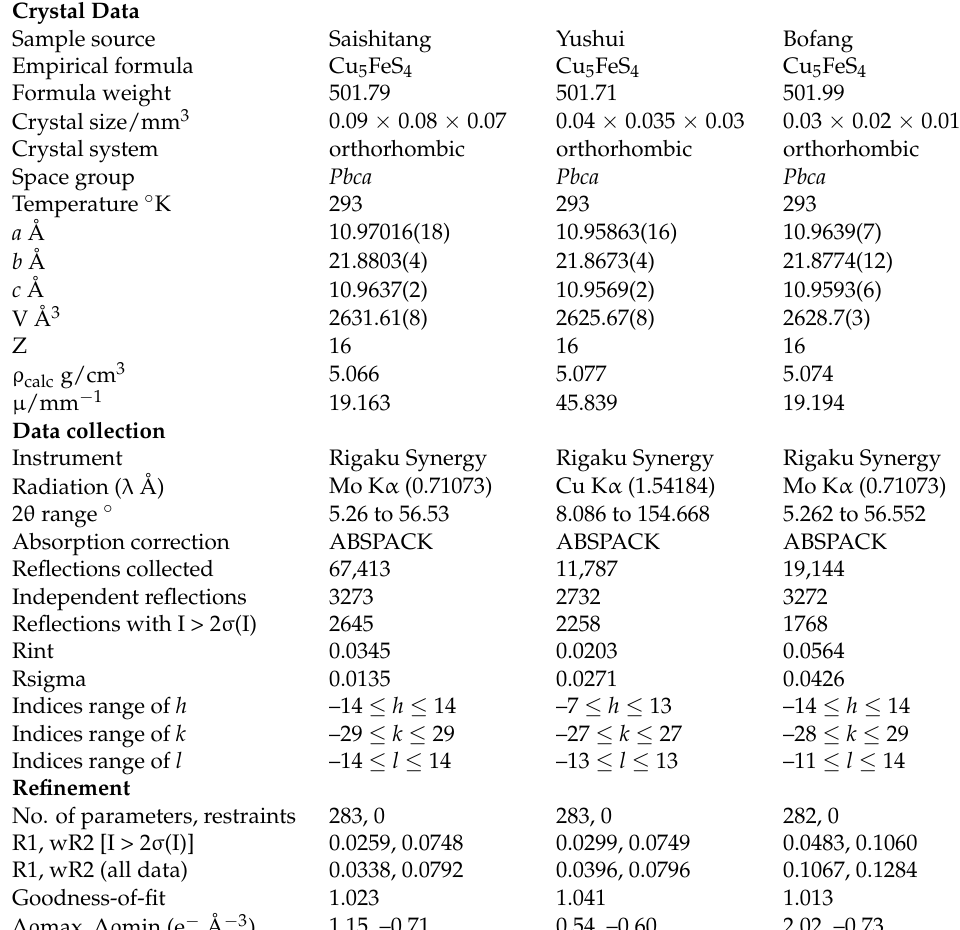
Table 2. Summary of crystal data and refinement results for bornite. Crystal